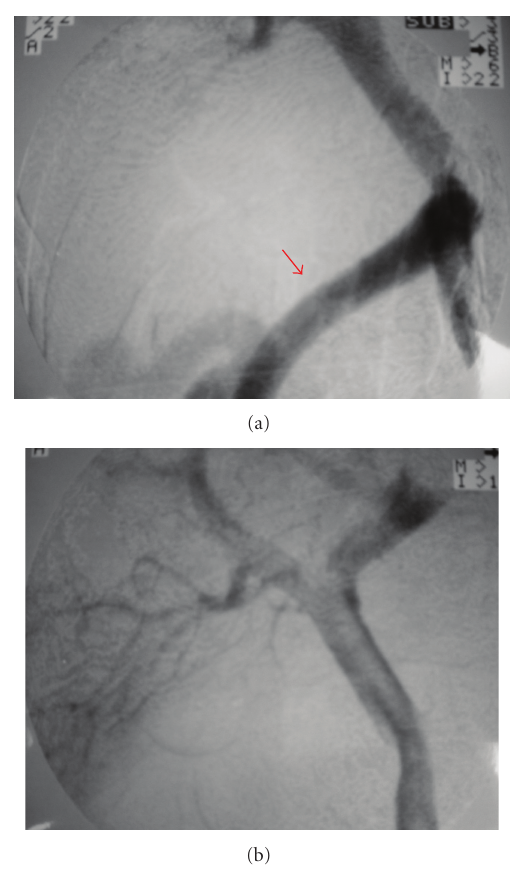
Figure 2: Portographic findings before ligation. Portography through the superior mesenteric artery showed a huge shunt which drained into the inferior vena cava (arrow). Portographic findings after ligation. After shunt occlusion, the huge shunt could not be